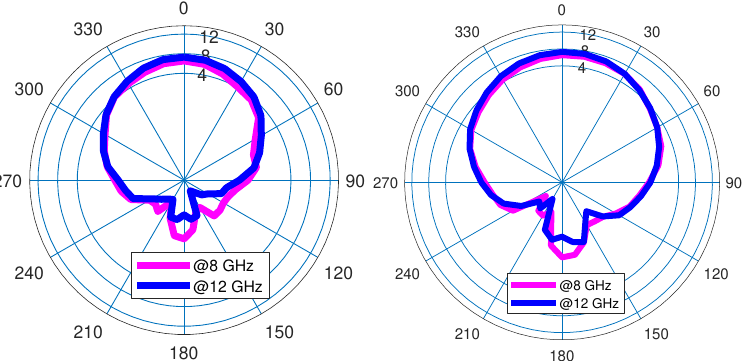
Figure 9. Predicated resistance ( right ) and reactance ( left ) of optimized MIMO through DNN.